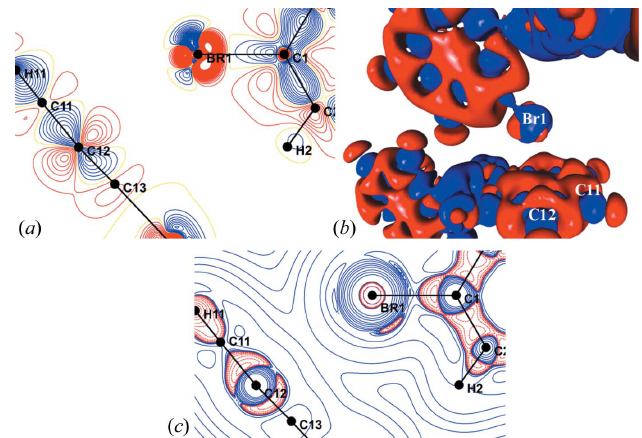
Figure 6 ( a ) Two-dimensional and ( b ) three-dimensional experimental deforma- tion density plots around the bonding region at the (cid:8) 0.05 e A˚ (cid:4) 3 level. Red denotes charge depletion (VSCD) and blue denotes charge